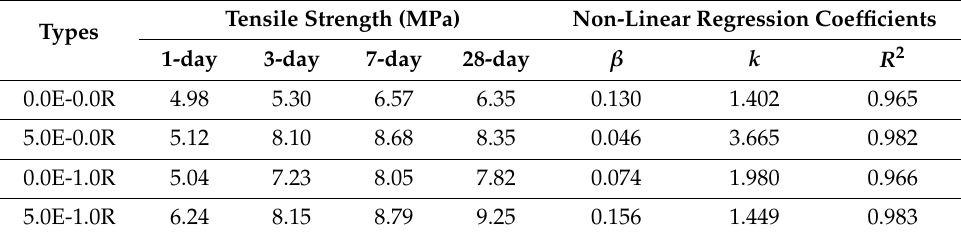
Table 5. Test results of the tensile strength and non-linear regression